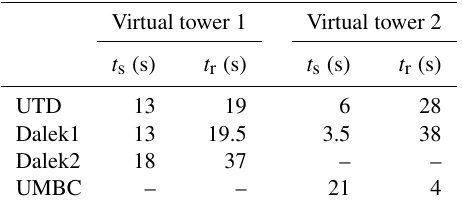
Table 4. Average sampling period, t s , and time interval between consecutive scans, t r , for the various lidars performing the different virtual towers.